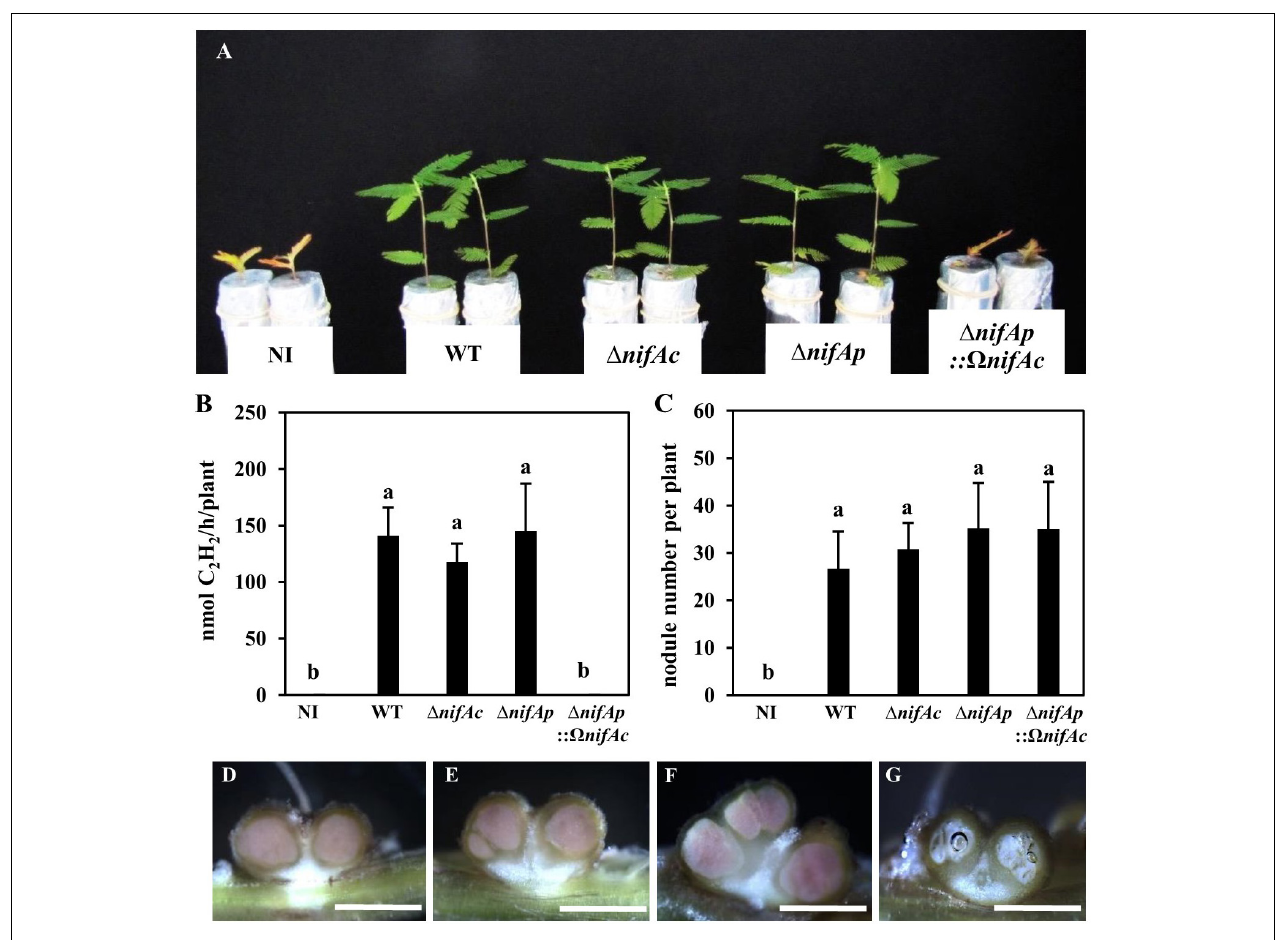
FIGURE 3 | The two nifA genes in Bradyrhizobium sp. DOA9 strain are functionally redundant during symbiosis with Aeschynomene americana. (A) Comparison of plant growth (aerial part) non-inoculated (NI) or inoculated with WT and mutant strains DOA9 (cid:49) nifAc , DOA9 (cid:49) nifAp and DOA9 (cid:49) nifAp :: (cid:127) nifAc DOA9 (at 20 dpi). (B) Amount of acetylene-reducing activity (ARA) in A. americana plants inoculated with WT and mutant strains. (C) Number of nodules per plant inoculated by WT and nifA mutant strains (D–F) Transversal sections of nodules elicited by WT (D) , DOA9 (cid:49) nifAc (E) , DOA9 (cid:49) nifAp (F) , and DOA9 (cid:49) nifAp :: (cid:127) nifAc (G) mutants. Scale bars are 1 mm for (D–G) . In (B,C) , error bars represent standard error ( n = 10). Different letters above error bars indicate significant differences at P < 0.05 (Tukey’s HSD